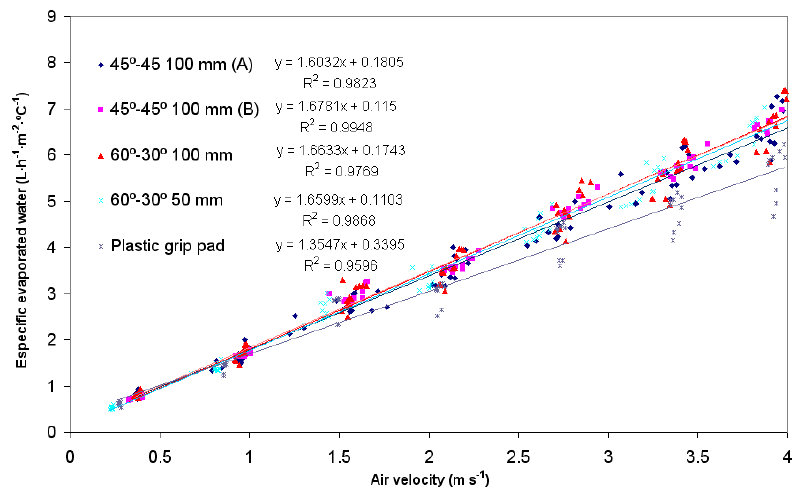
Figure 12. Comparison of the specific water consumption of the cellulose pads and the plastic grid block at different air velocities and water